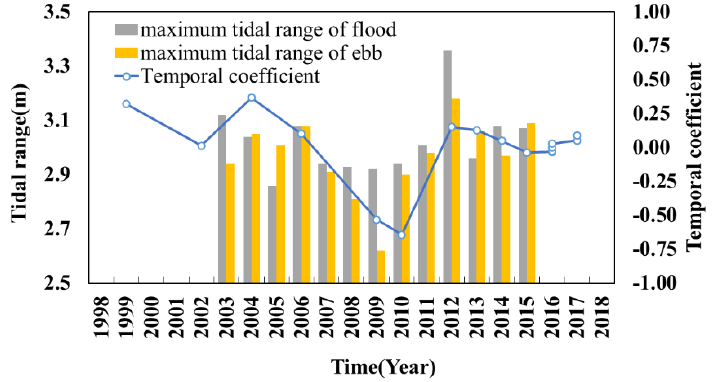
Figure 11. Annual maximum tidal range of flood and ebb respectively, and the fourth temporal coefficient.